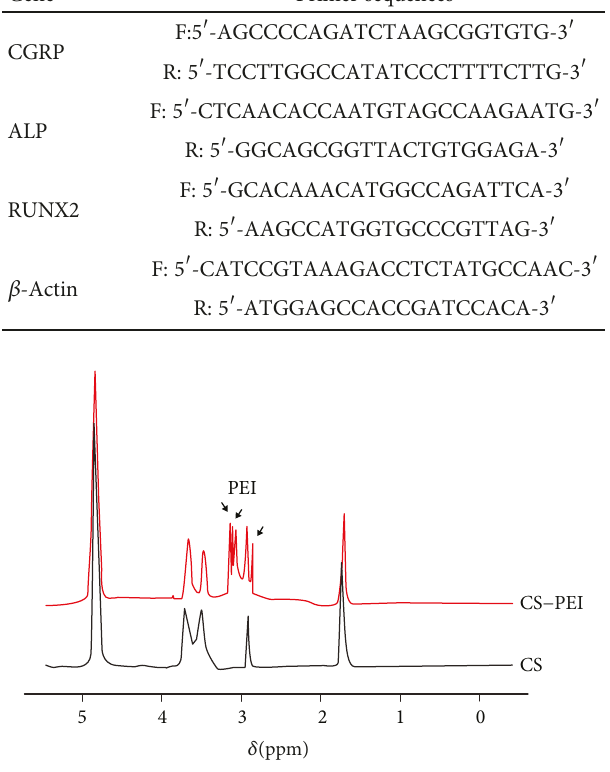
Figure 2: 1 H-NMR spectra of CS and